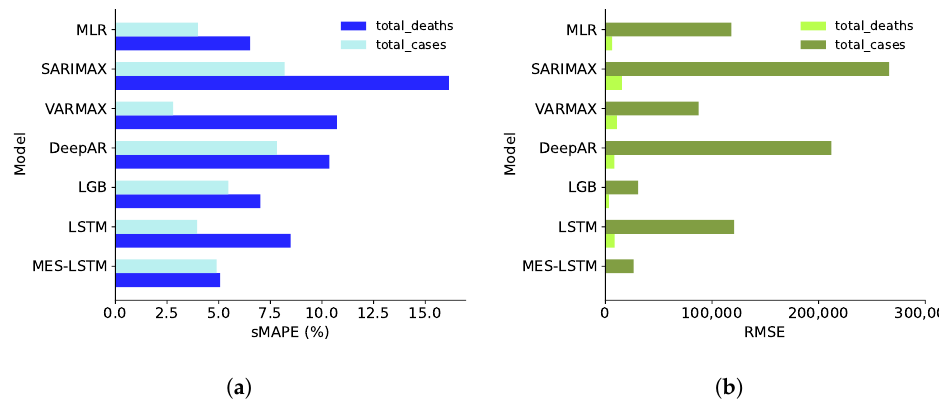
Figure 6. Forecast Accuracy in South Africa. ( a ) sMAPE. ( b ) RMSE.